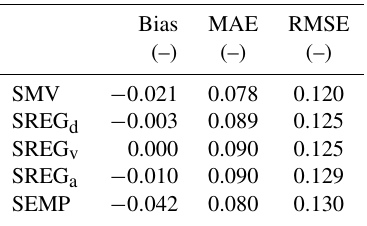
Table 6. Validation of the models: performance of the uni- and mul- tivariable models in estimating relative damages to buildings, de- veloped based on two-thirds and validated based on the remaining one-third of the local data. Models are listed as in Table